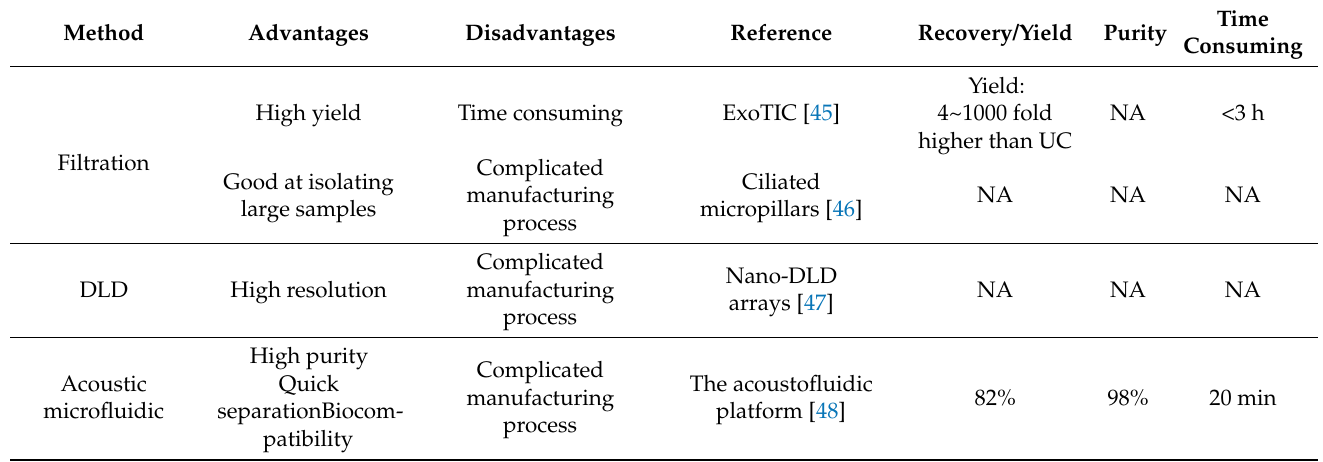
Table 2. Microfluidic isolation methods for